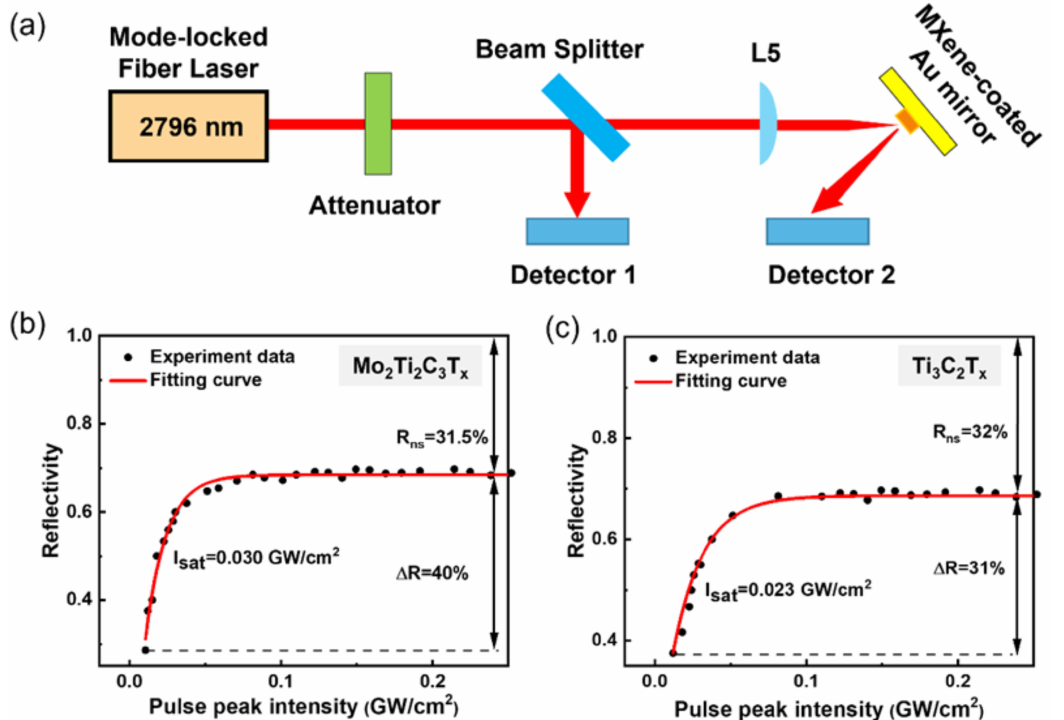
Figure 2. ( a ) The experimental setup for the nonlinear saturable absorption characteristics measure- ment at 2796 nm. The reflectivity of the ( b ) Mo 2 Ti 2 C 3 T x and ( c ) Ti 3 C 2 T x as a function of peak pulse